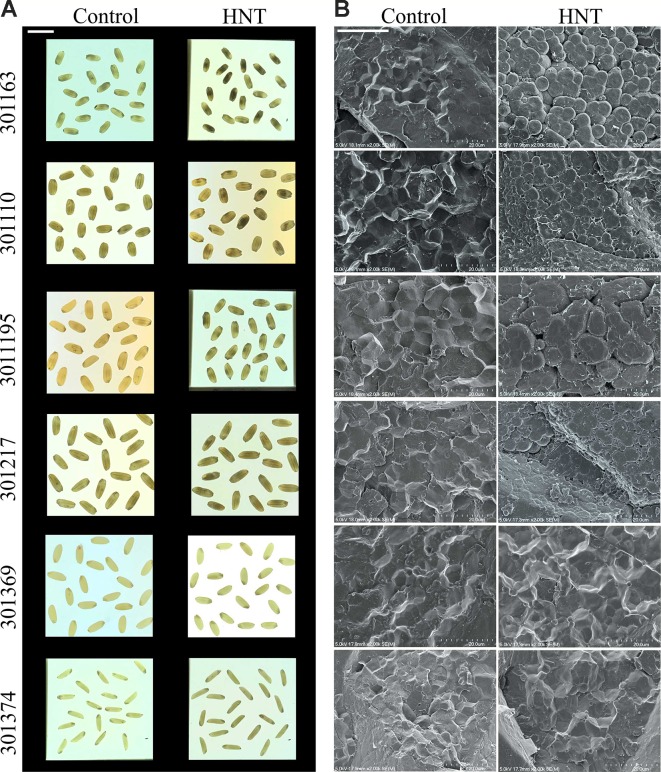
High night-time temperature alters seed quality traits. (A) Mature seed images from six rice genotypes subjected to control and HNT conditions (scale: 1 cm). Light box was used to take these images. (B) Representative images of scanning electron microscopy (SEM) of mature seed from three independent biological replicates (scale: 20 μm). HNT, high night-time temperature.